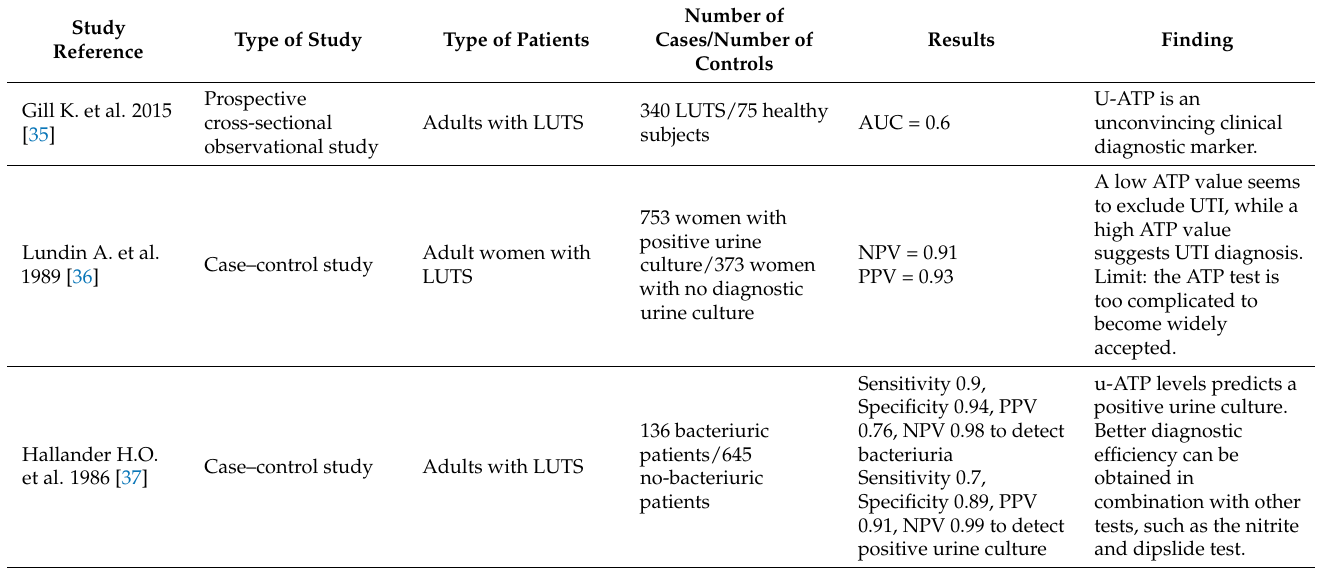
Table 4. Urine ATP diagnostic value in UTIs; target population: